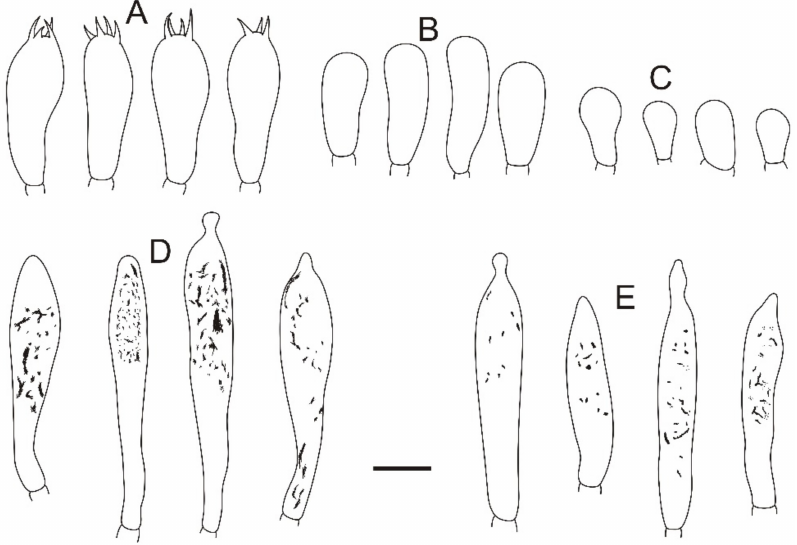
Figure 20. Microscopic features of Russula subversatilis (BJTC C653). ( A ) Basidia. ( B ) Basidiola. ( C ) Marginal cells. ( D ) Hymenial cystidia on lamellae sides. ( E ) Hymenial cystidia on lamellae edges. Scale bar: 10 µ